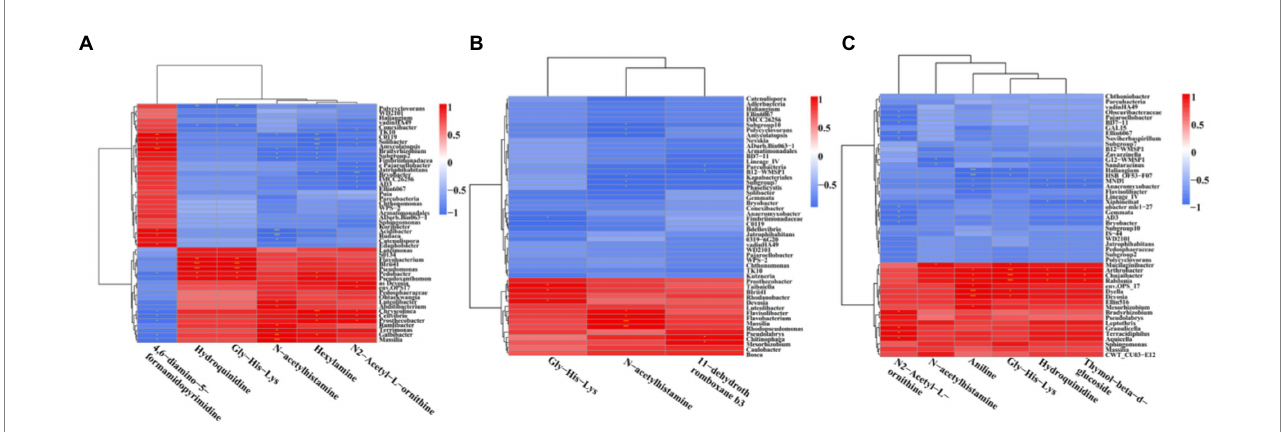
FIGURE 8 Correlation heat map between DEMs and related bacteria in different treatment groups. (A) MF-HZ23 vs. the control; (B) MF-HZ23 plus CCF vs. the control; and (C) CCF vs. the control. Red and blue represent positive correlation and negative correlation, respectively. * indicated a significant correlation at p <